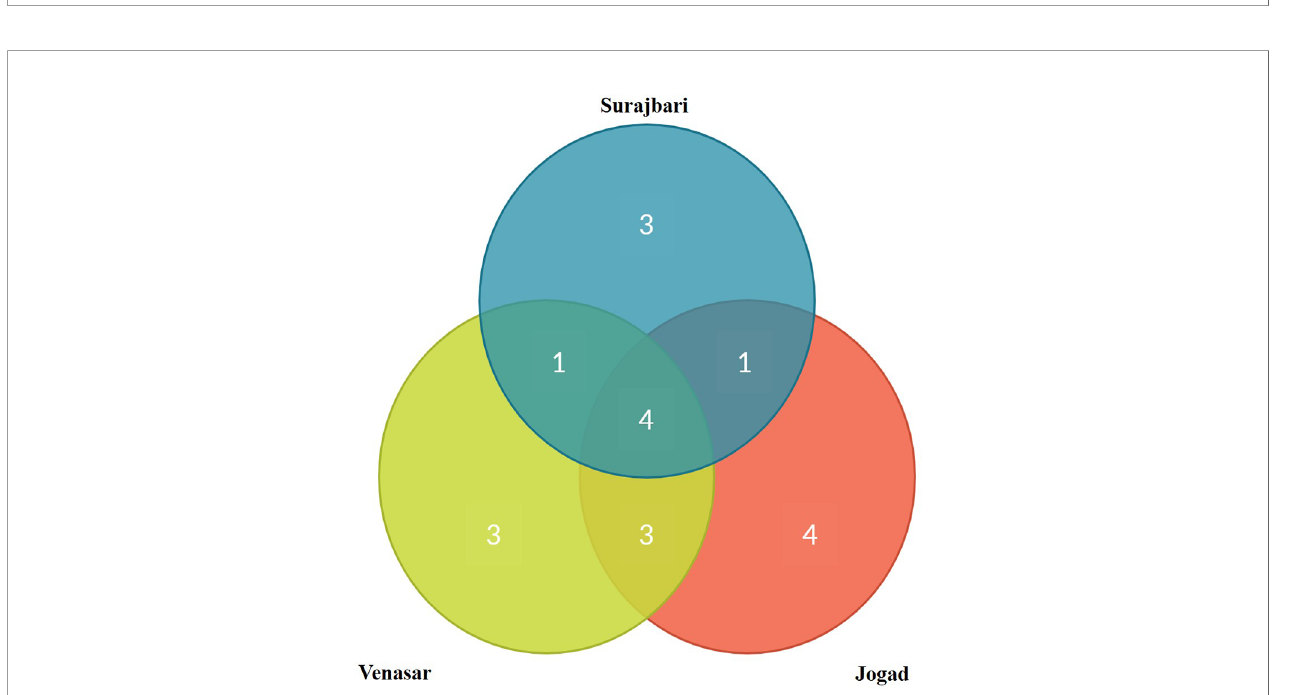
FIGURE 7 | Relative abundance pro fi le of genera obtained from three sampling sites Surajbari, Venasar, and Jogad.